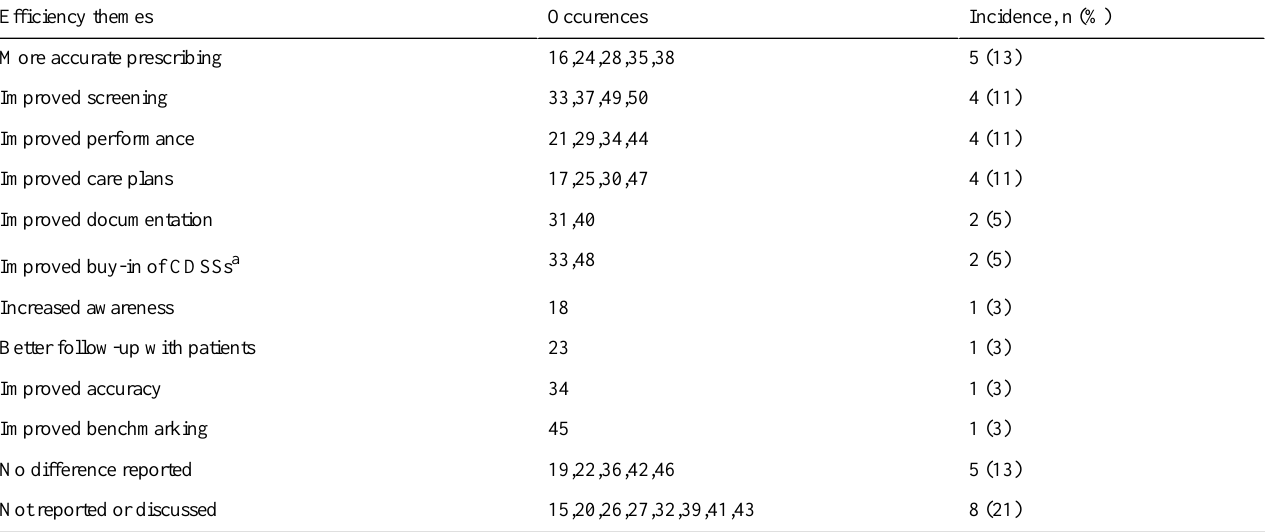
Table 2. Summary of themes identified for practitioner performance (n=38).